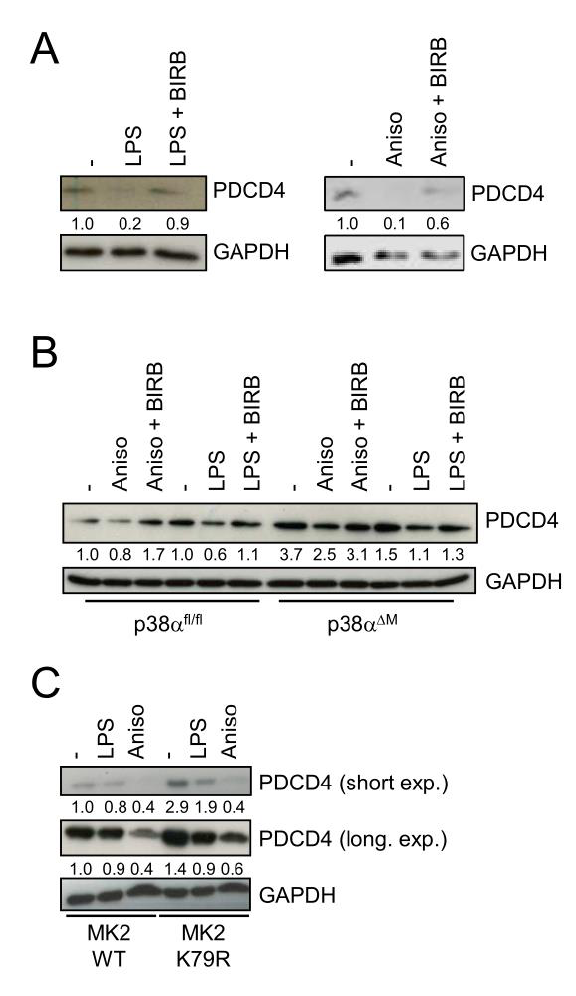
FIGURE 1 : p38 promotes PDCD4 degradation. (A) Bone marrow- derived macrophages (BMDMs) were treated with BIRB796 (BIRB) as depicted and then stimulated with LPS or anisomycin (Aniso) only for 4 hours. (B) p38 f l/fl and p38 αΔM BMDMs were stimulated with Aniso or LPS for 4 hours. (C) Mk2 -/- macrophages reconsti- tuted with either MK2 K79M mutant or WT MK2 were stimulated with Aniso or LPS for 4 hours. Cell lysates were analyzed by im-